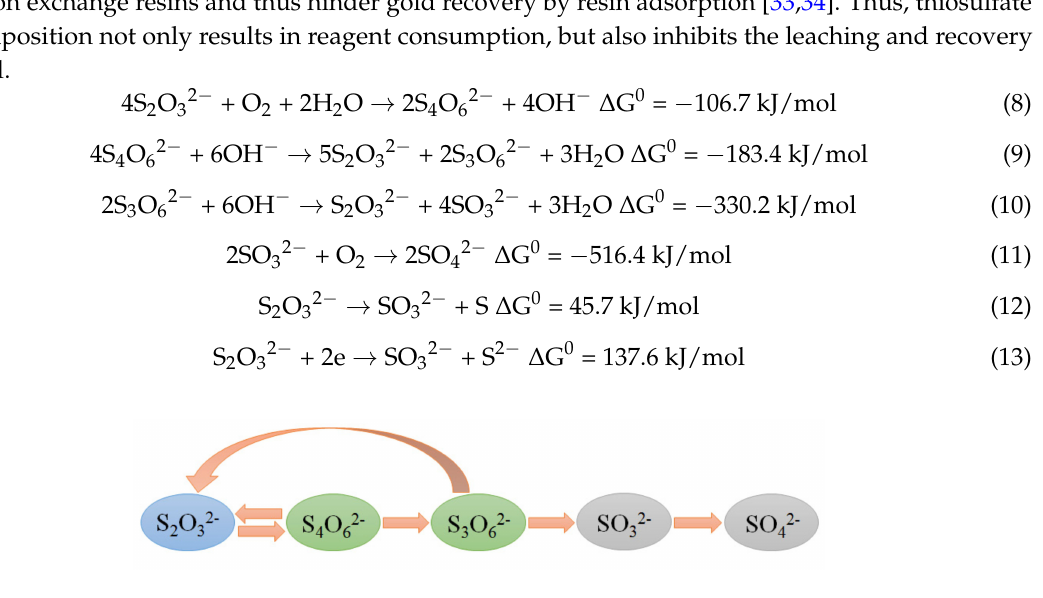
Figure 2. Simplified route of thiosulfate decomposition.